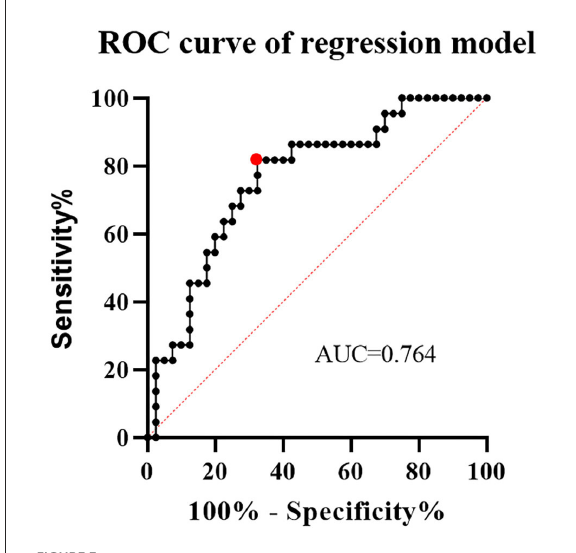
FIGURE3 The receiver operating characteristic (ROC) curve of a logistic regression classification model. At the cutoff value, the area under the curve (AUC) was 0.764, with sensitivity and specificity of 0.82 and 0.68,